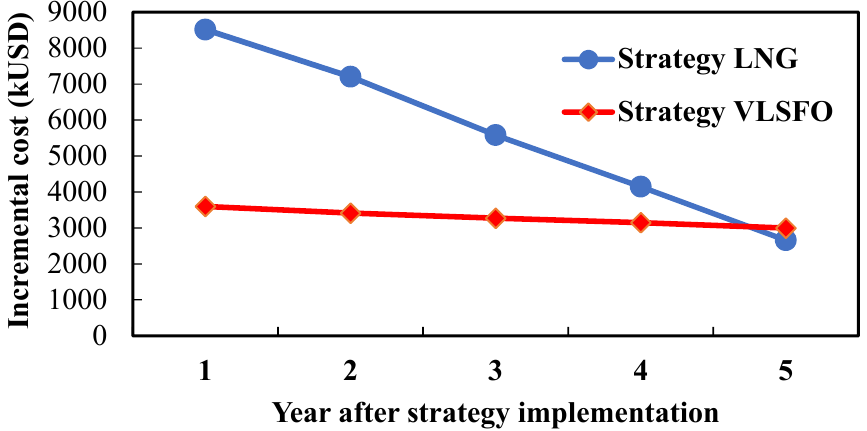
Figure 4. Total incremental costs of the VLSFO and LNG strategies over a five-year period.